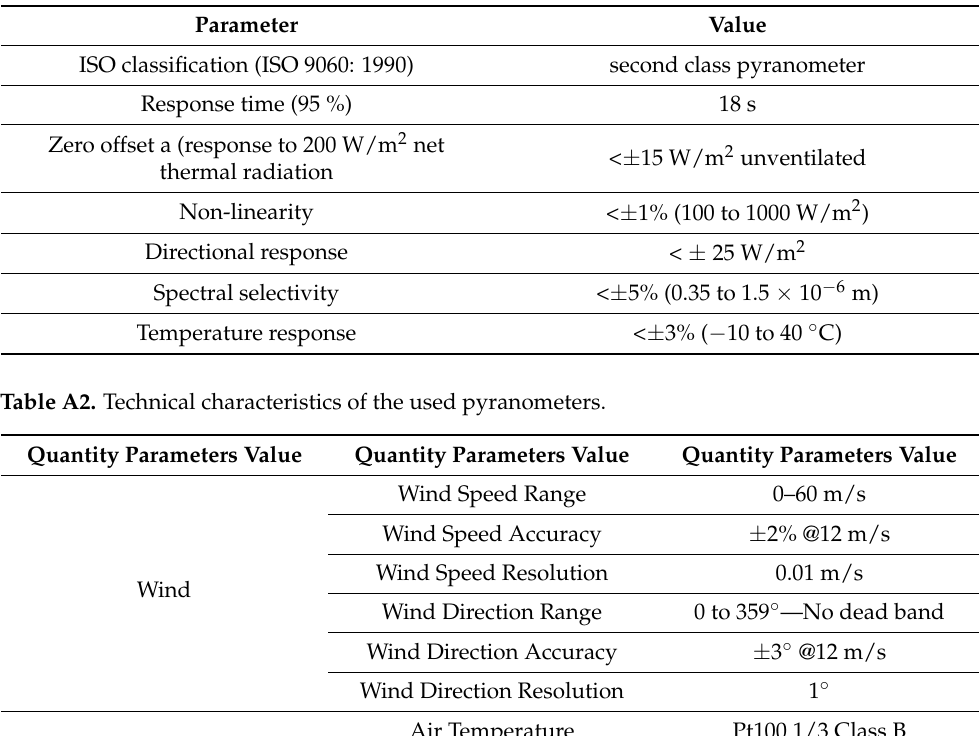
Table A1. Technical characteristics of the used pyranometers.